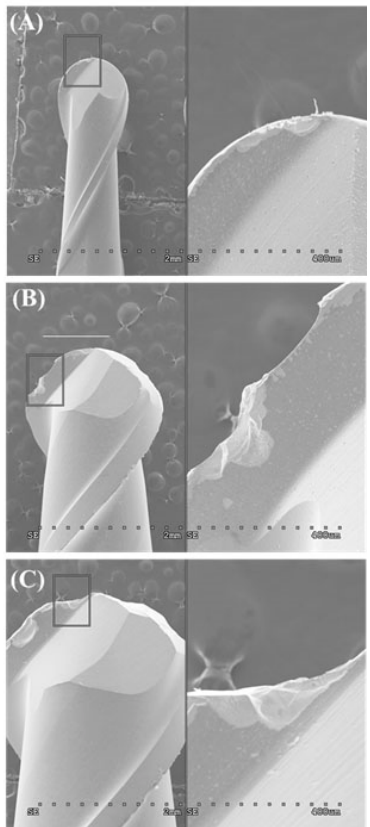
Figure 5. Edge chippings of milling burs with various diameters after milling of six three ‐ unit FDPs. ( A ) 1.0 mm, ( B ) 2.0 mm, and ( C ) 3.0 mm.